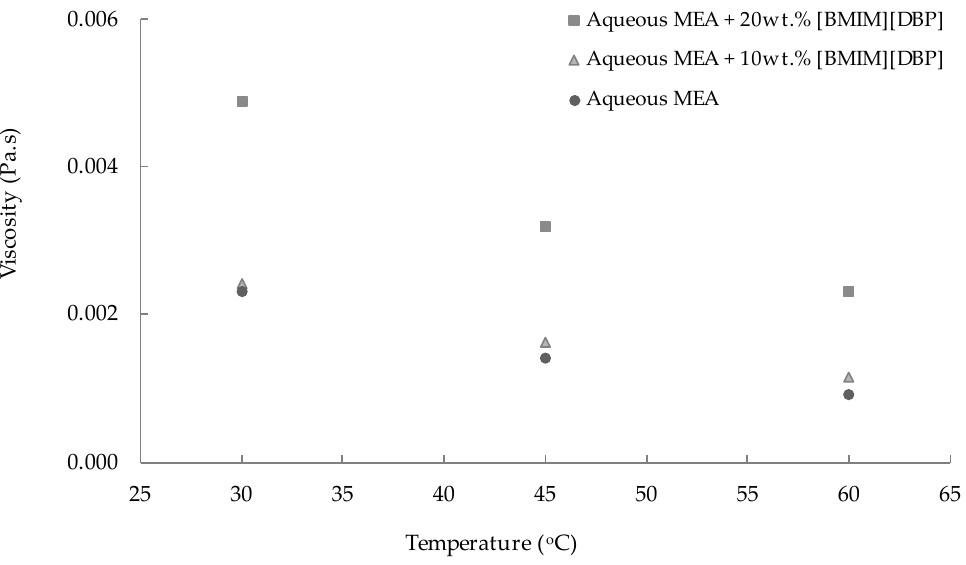
Figure 3. Viscosity of aqueous 30 wt%MEA-(BMIM)(DBP) hybrid solvent at different (BMIM)(DBP) concentrations, temperatures of 30 ◦ C, 45 ◦ C and 60 ◦ C and a pressure of 1 atm.